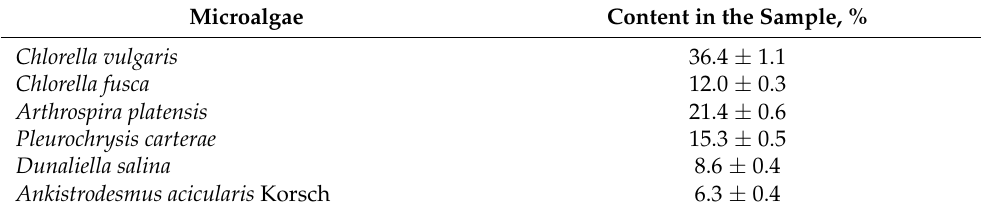
Table 5. Composition of microalgae in samples collected from the Baltic